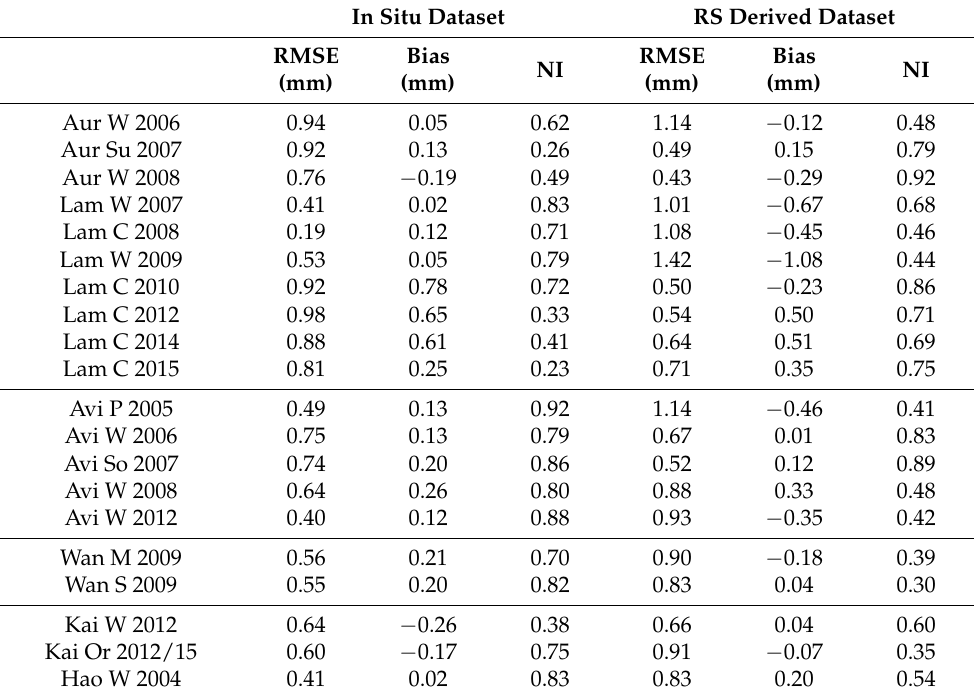
Table 3. Statistics of the reconstruction of daily ET from instantaneous in situ latent heat flux and instantaneous remotely-sensed derived latent heat flux on clear sky days at 13:30. In Situ Dataset RS Derived Dataset